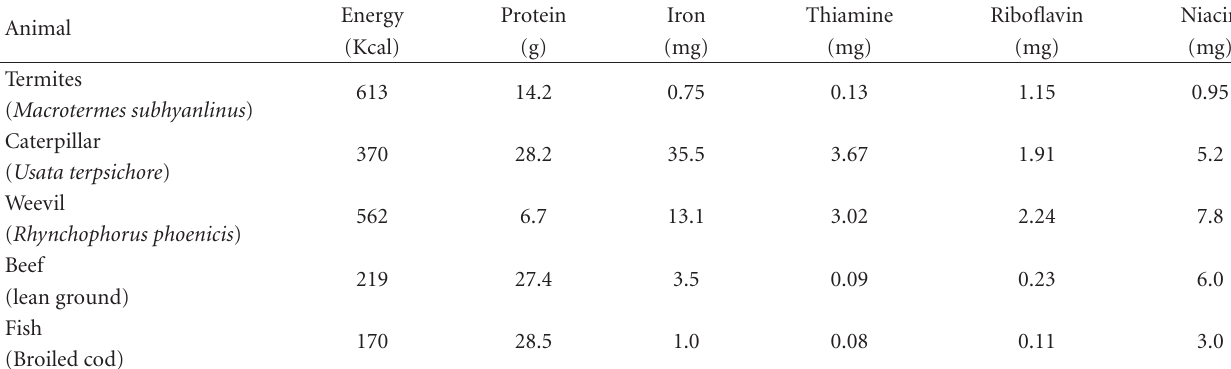
Table 2: The nutritional content of edible insects and other animals based on 100 gram serving.